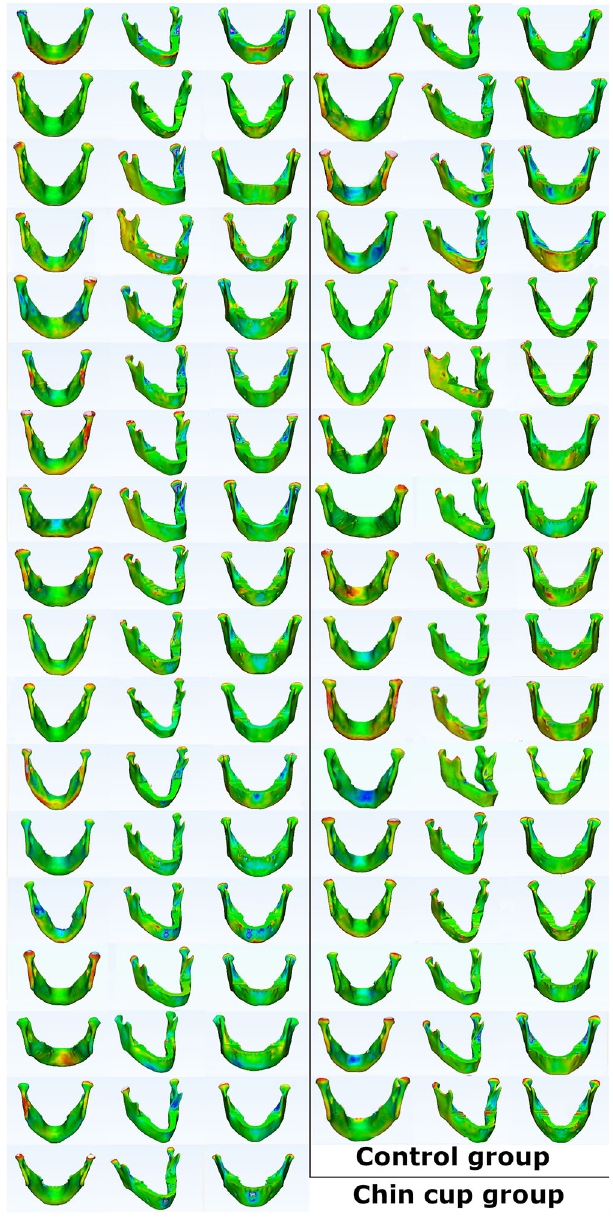
Figure 6. Frontal, isometric and back views of point-based analysis color